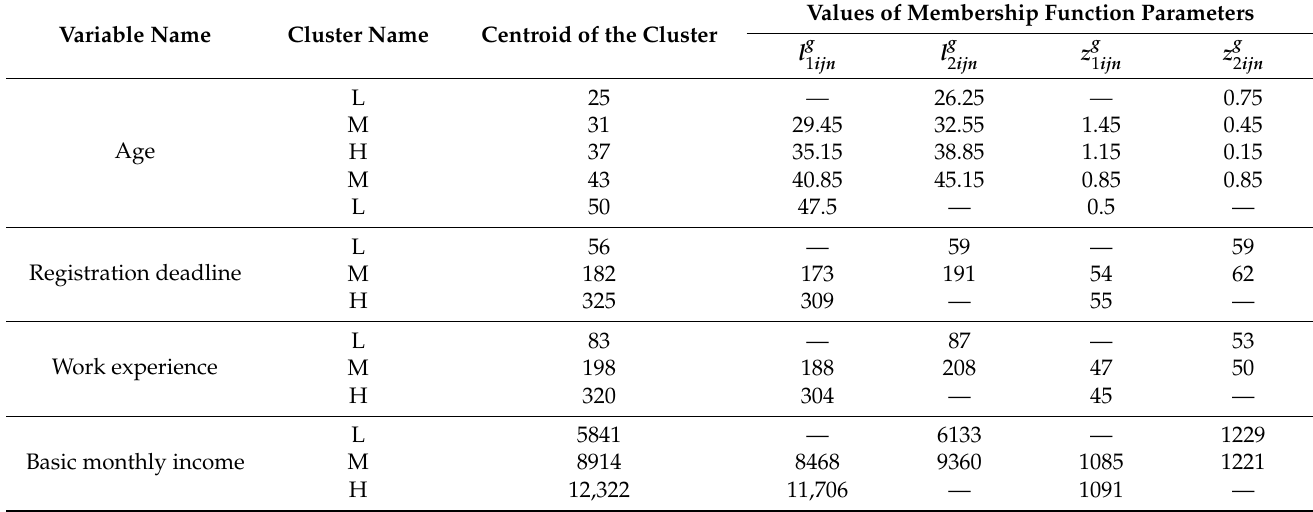
Table A2. Parameters of clusters and parameters of membership functions of input variables in relation to quantitative characteristics of borrowers based on the results of neural processing of the